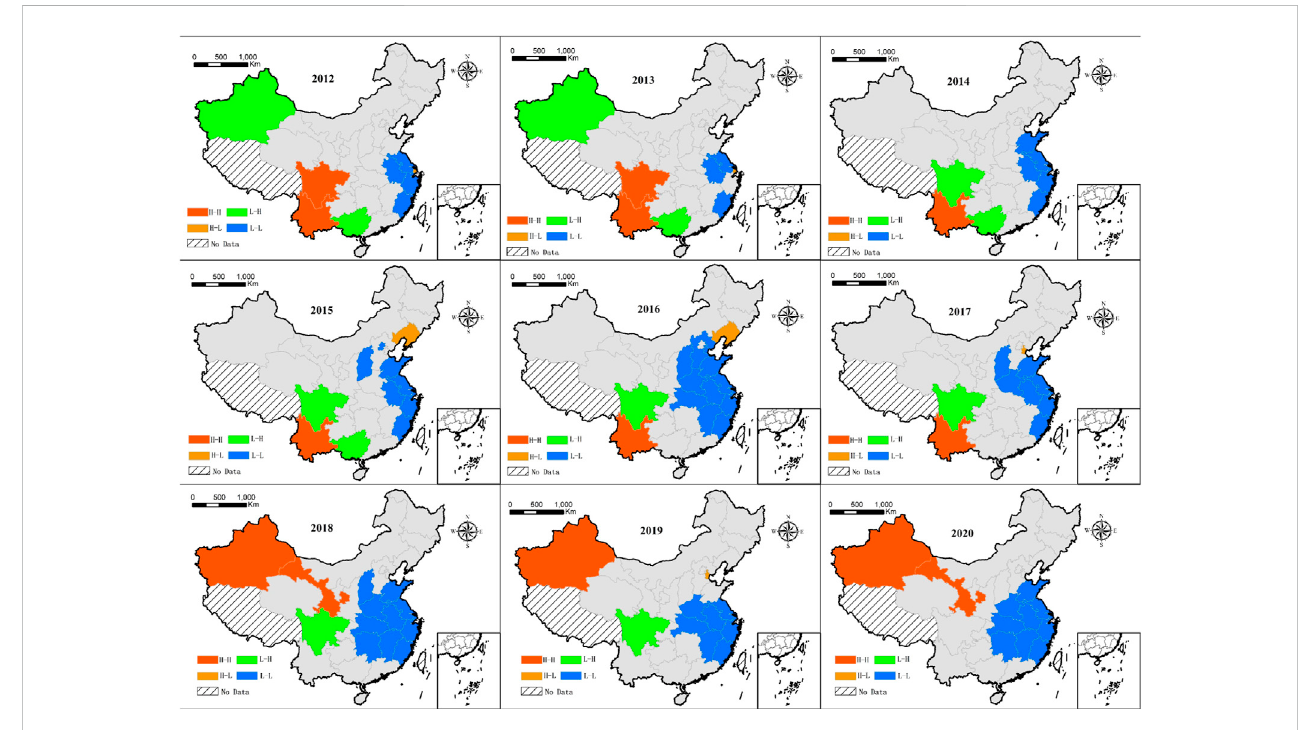
FIGURE 3 Maps of LISA for risk1 of China from 2012 to 2020.